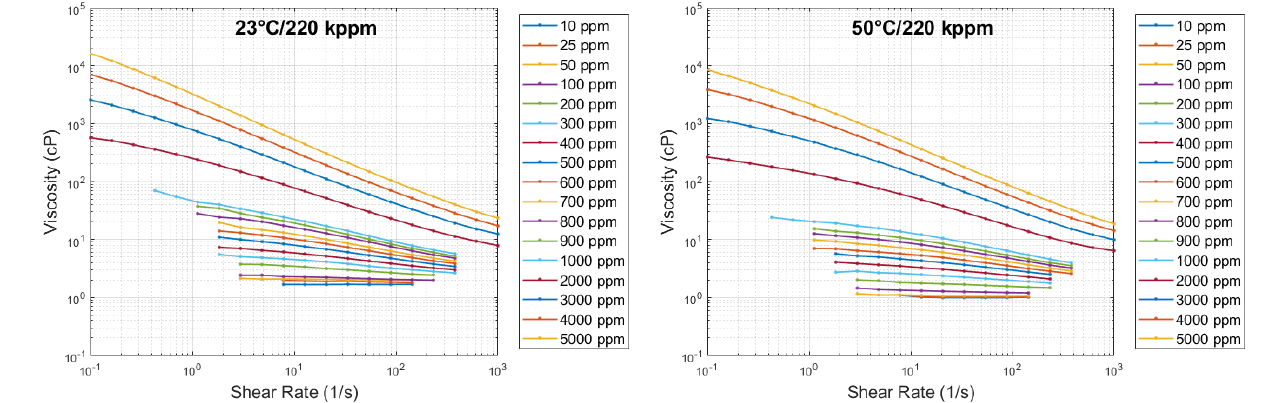
Figure 5: Flow curves graph at 23 ∘ C and 220,000 ppm of NaCl